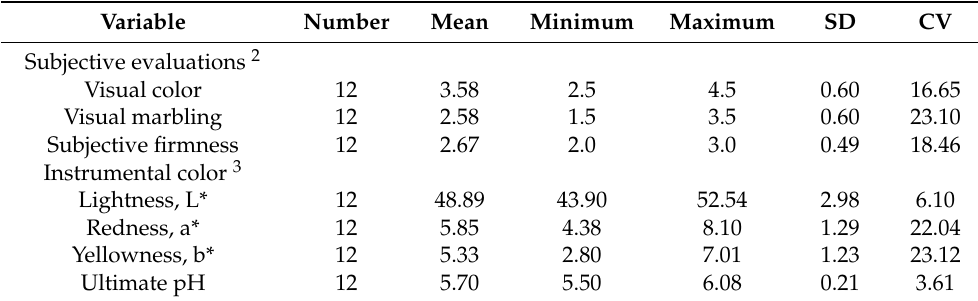
Table 1. Population summary statistics of fresh (not cooked) pork quality measurements of loins used to provide chops for sensory evaluation 1 .